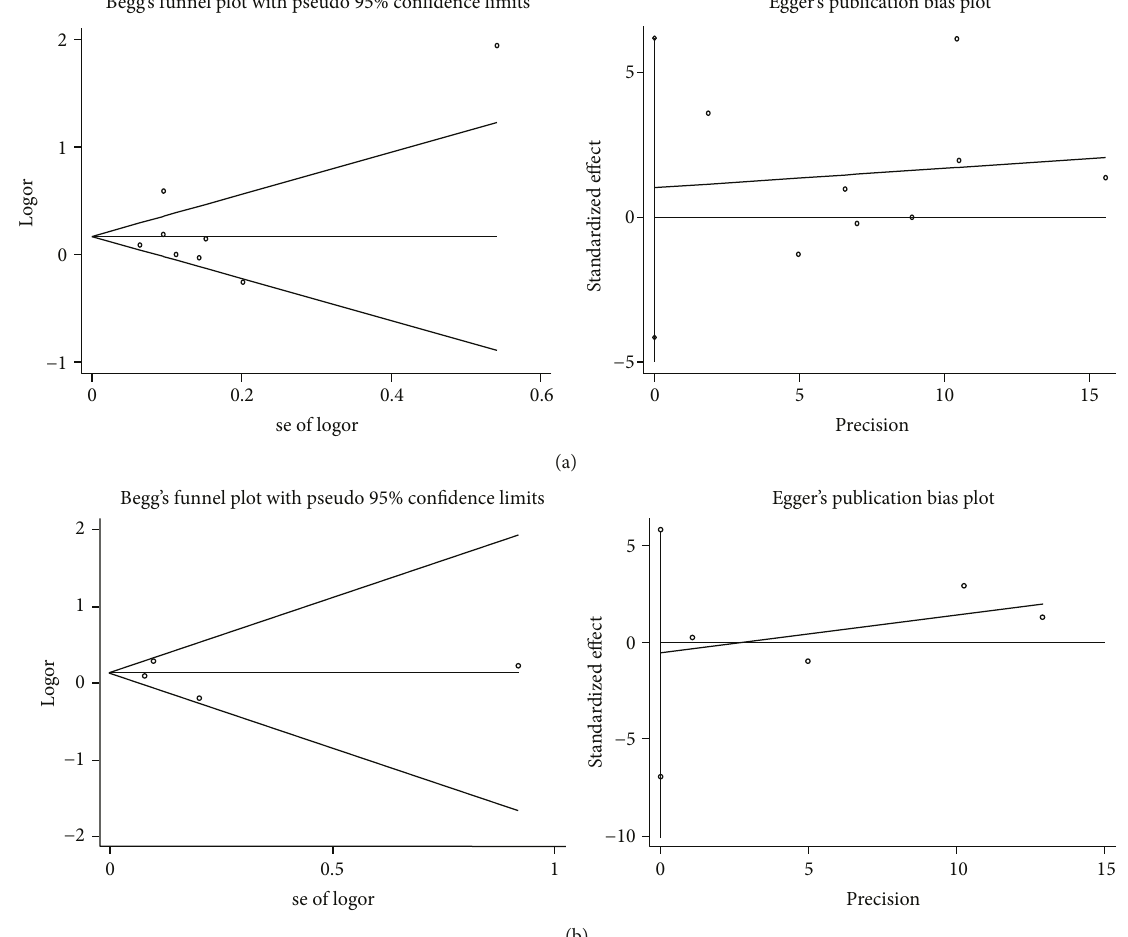
Figure 8: Publication bias of TLR9 polymorphisms in the allele model. (a) rs352140 (Begg ’ s test: p = 1 000 , Egger ’ s test: p = 0 647 ). (b) rs187084 (Begg ’ s test: p = 1 000 , Egger ’ s test: p = 0 736